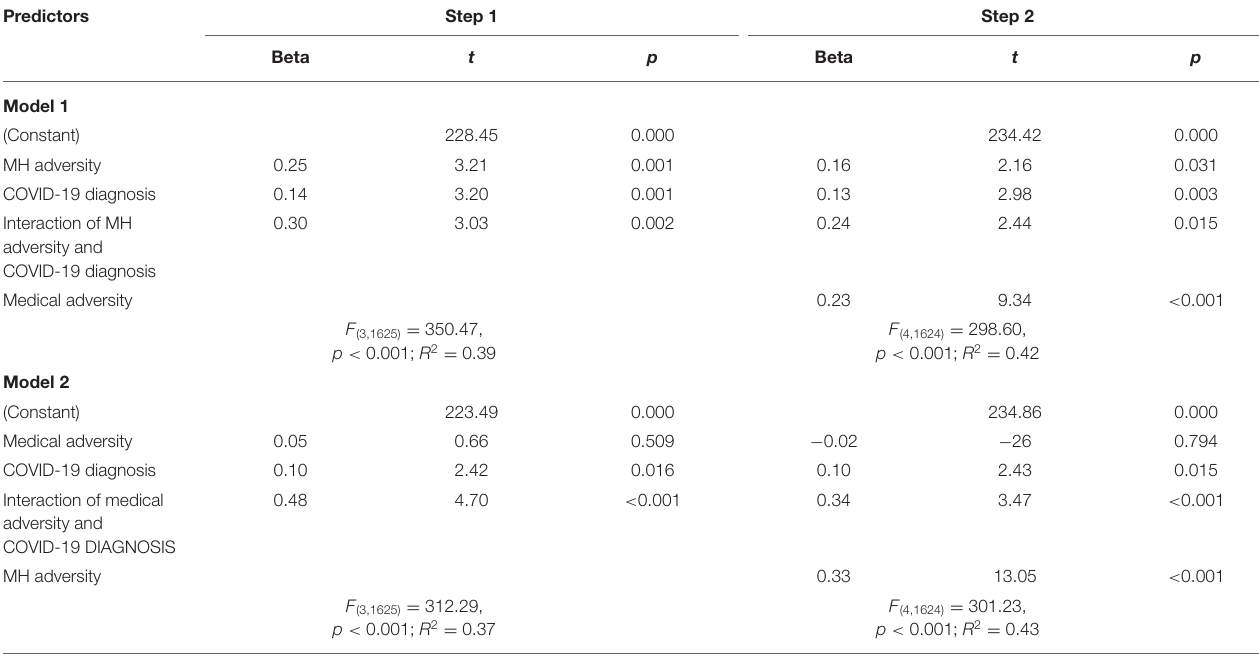
TABLE 2 | Results of stepwise linear regression analyses predicting autonomic reactivity from prior adversity and COVID-19 diagnosis. Predictors